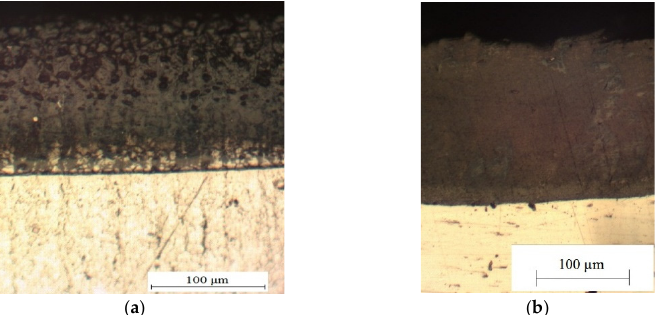
Figure 5. Microstructure of the nitrided layer on a specimen from steel 12X18H10T: ( a ) a specimen made by conventional method, layer depth 0.19 mm, microhardness 1251 HV5; ( b ) LB-PBF specimen, dark field image, layer depth 0.16 mm, microhardness 1352 HV5.